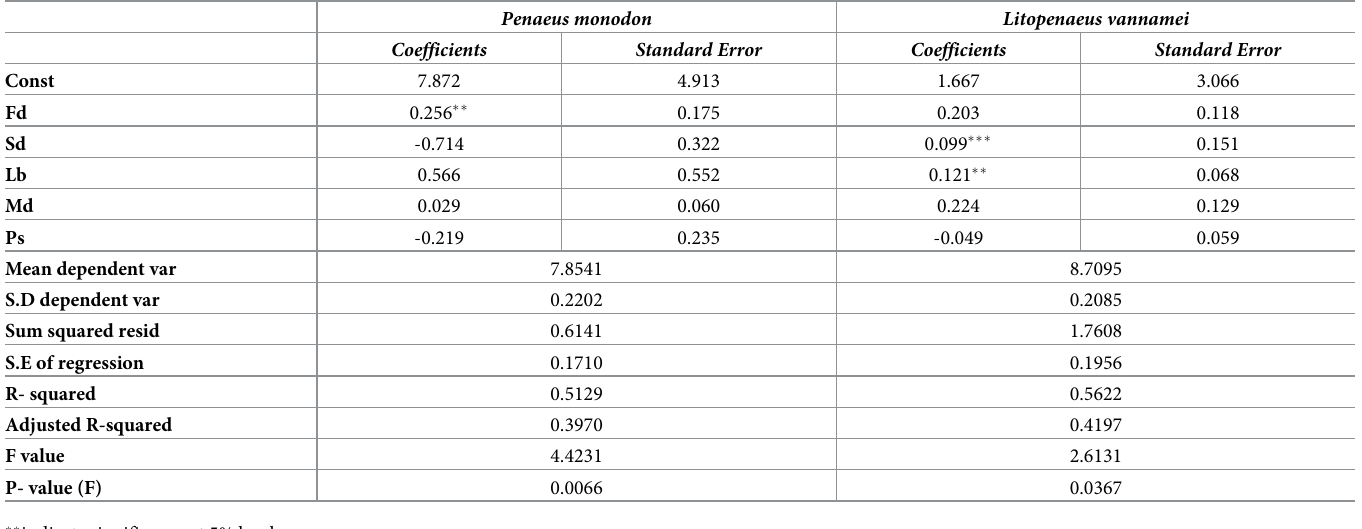
Table 7. Cobb-Douglas production function estimation for Penaeus monodon and Litopenaeus vannamei